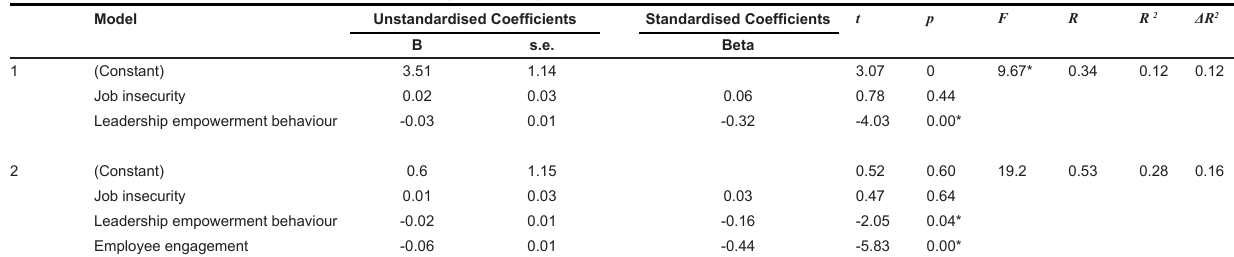
TABLE 5 Multiple regression analyses with turnover intention as dependent